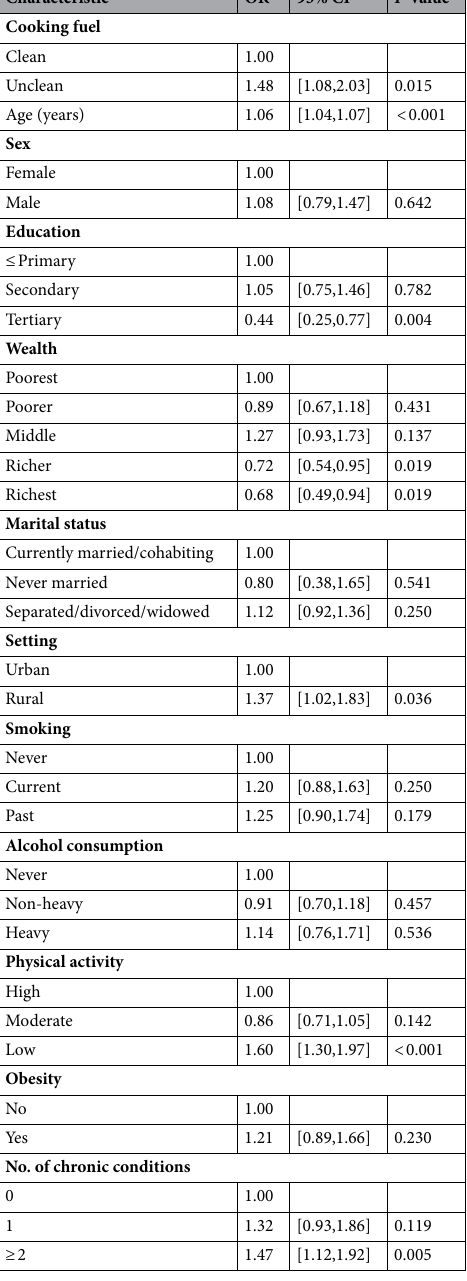
Table 2. Association between type of cooking fuel (or covariates) and mild cognitive impairment estimated by multivariable logistic regression. Model is adjusted for all variables in the Table and country. OR odds ratio, CI confidence